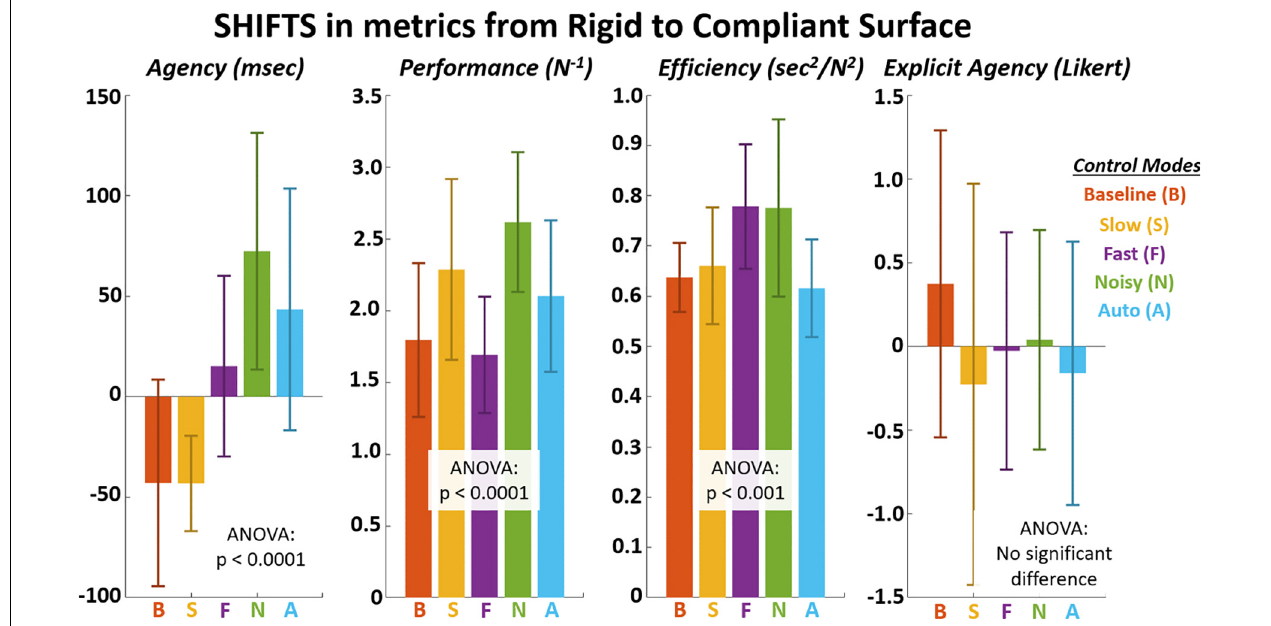
FIGURE 7 | Shifts in metrics across control modes from rigid to compliant grasp surface. The surface-control mode interaction p -values are as follows: implicit agency = 1E-05, performance = 5E-05, efficiency = 2E-04, explicit agency = 0.57.